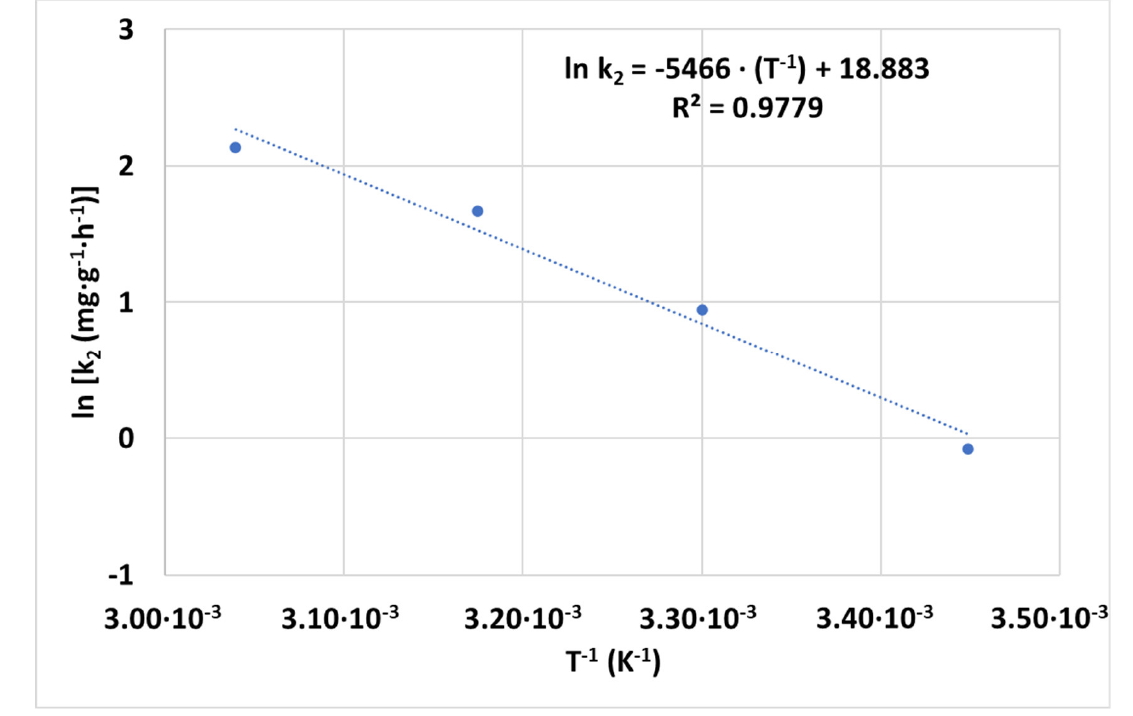
Figure 7. Evolution of ln(k 2 ) with T −1 (K −1 ) and linear fitting of Arrhenius equation.